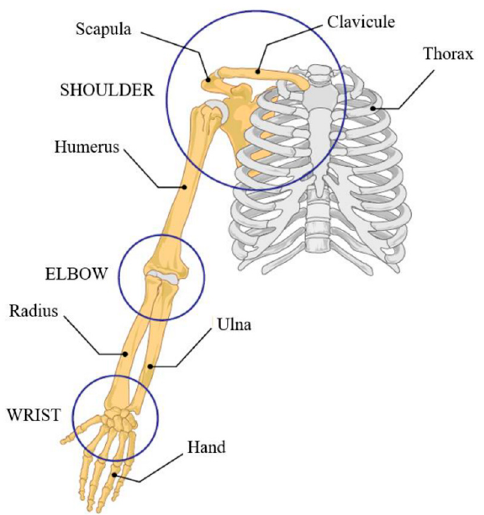
Figure 1. Anatomy of the upper limb.